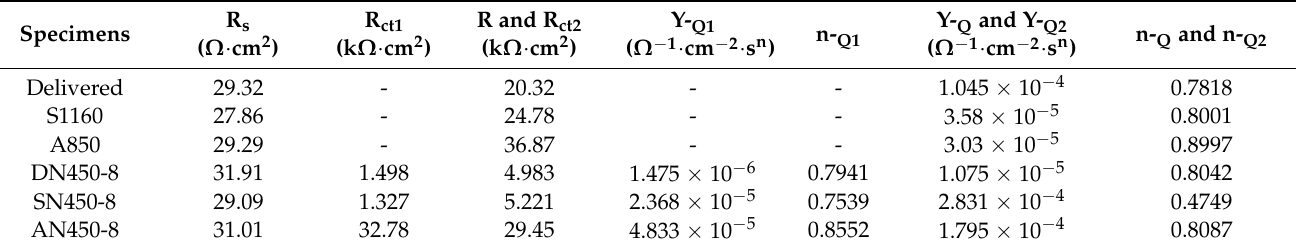
Table 6. EIS fitting parameters of AISI 430 stainless steel with a different initial microstructure before and after plasma nitriding in a 3.5% NaCl